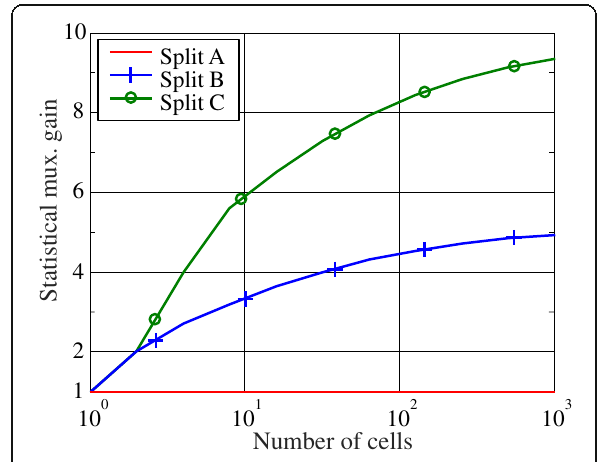
Fig. 8 Statistical multiplexing gains for high-load